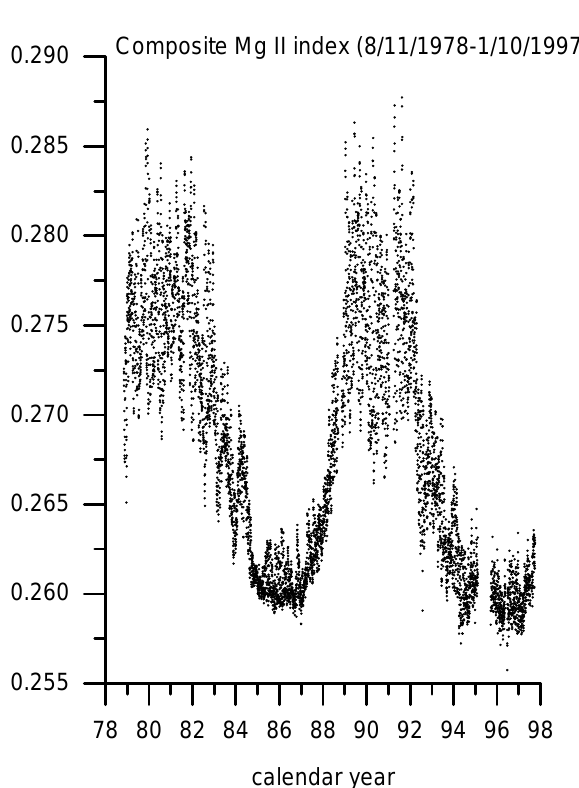
Fig. 4. The rescaled Mg II index (top) and the difference with